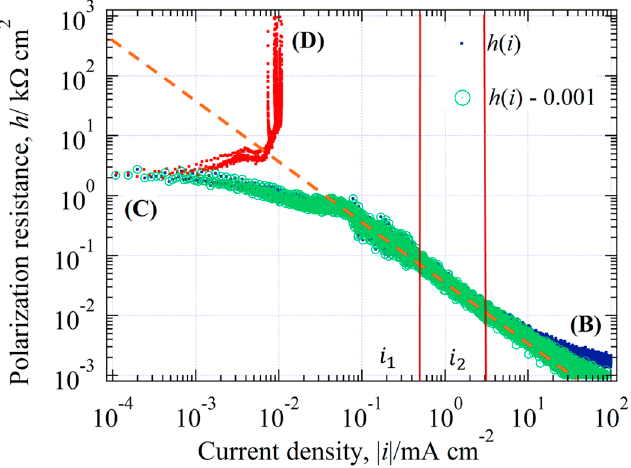
Figure 8. The revised expression of h exp ( i ) − 0.001 with green circles and the not-revised h exp ( i ) with blue dots are shown. The vertical lines i 1 and i 2 are drawn for a more accurate estimation. The (B), (C) and (D) correspond to that in Figure 1.